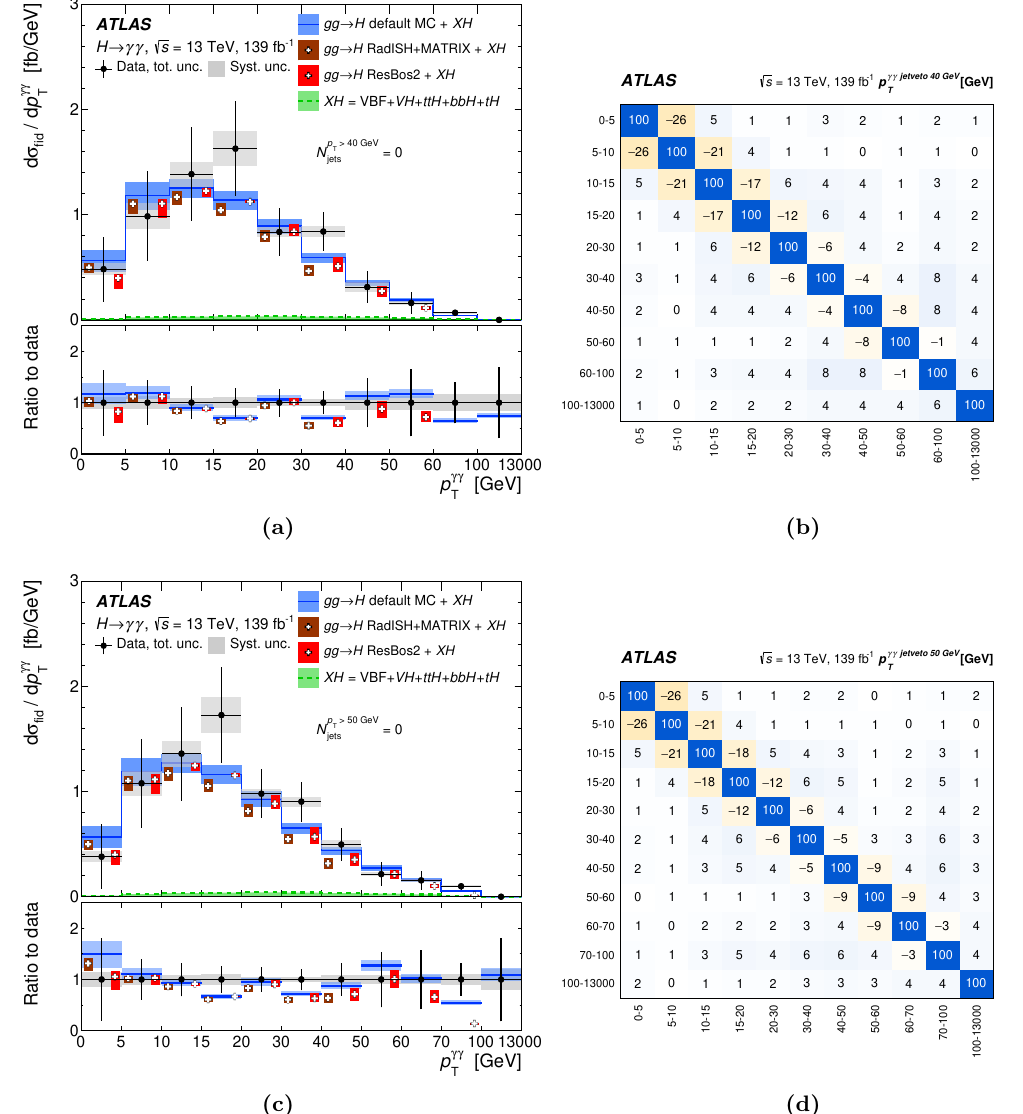
with a T with a 40 GeV T T